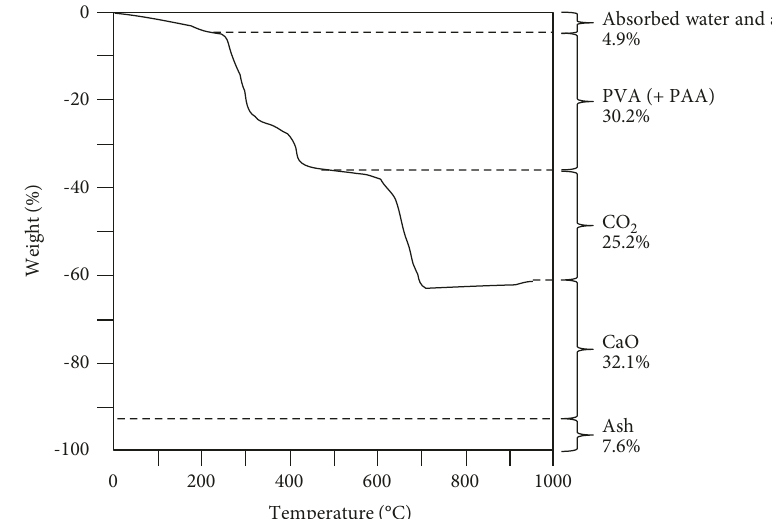
– polymer nanocomposite sample. 3